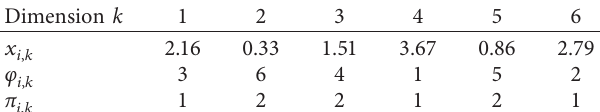
Table 1: Solution’s encoding scheme. Dimension